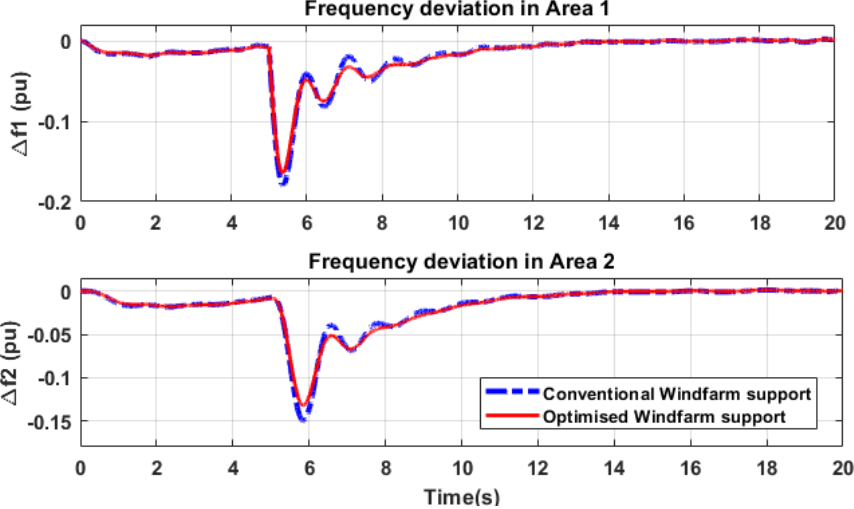
Figure 21. Frequency deviation during wind power